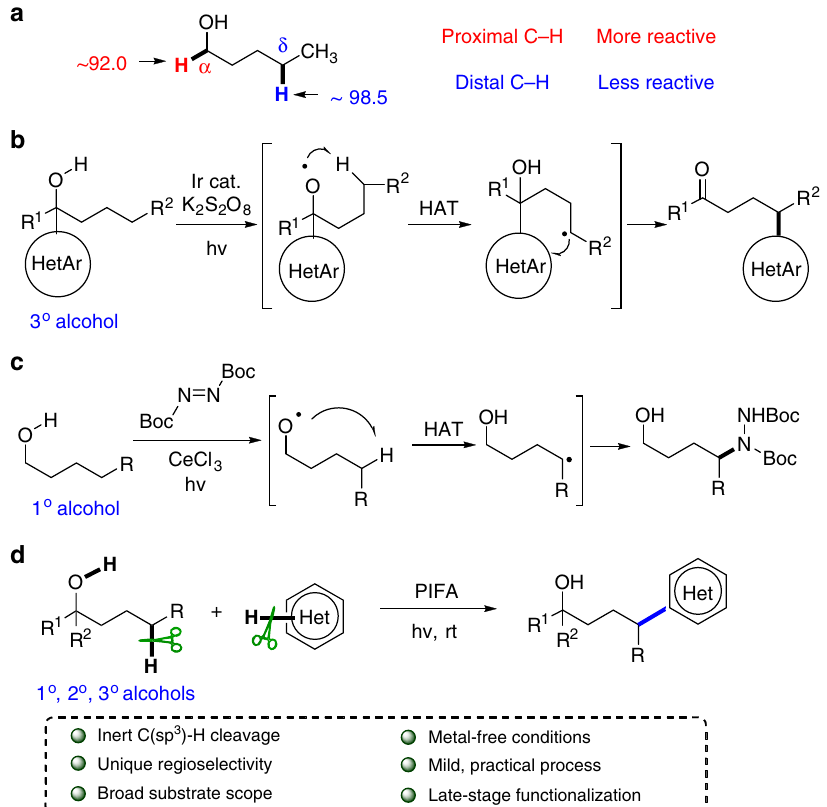
Fig. 1 Free alcohol-directed functionalization of remote C(sp 3 ) – H bonds. a BDEs (kcal mol − 1 ) of C(sp 3 ) – H bonds in alcohols. b Intramolecular heteroarylation of tertiary alcohols. c Intermolecular amination of primary alcohols. d Intermolecular heteroarylation of